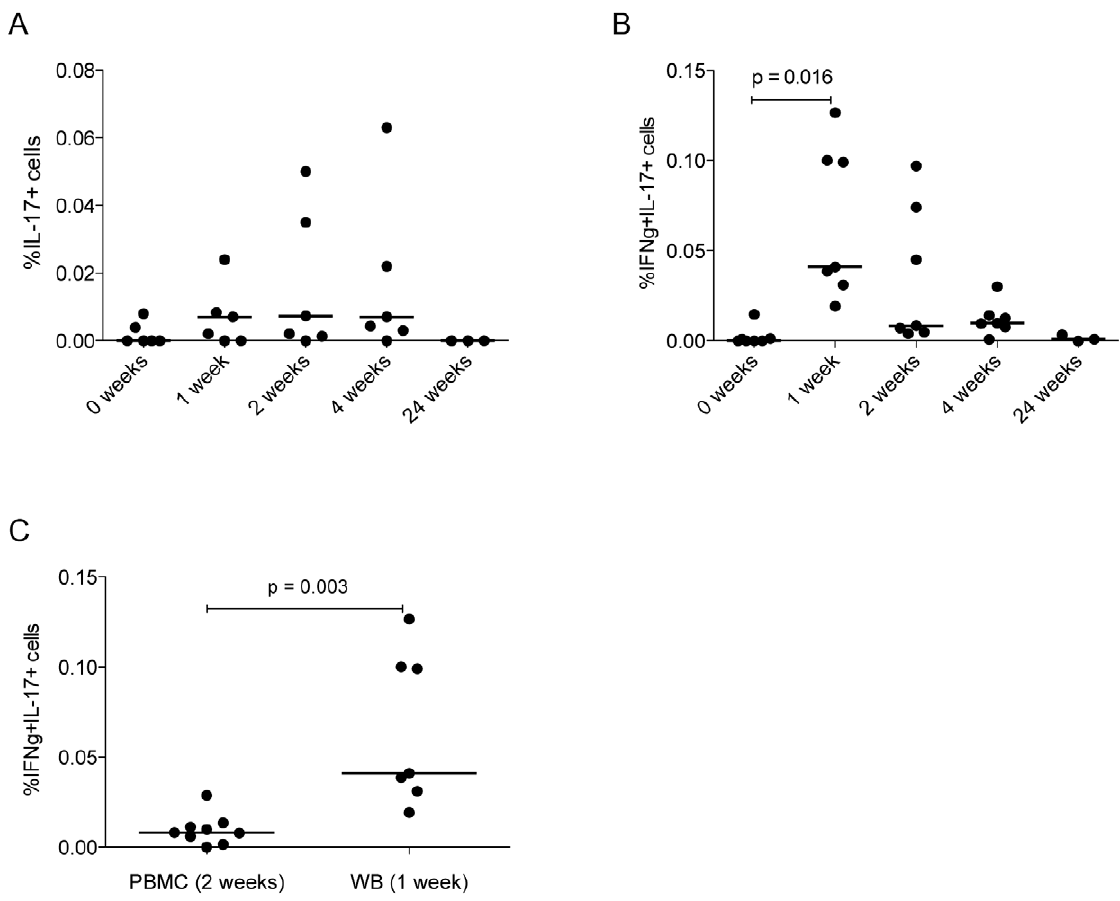
Figure 3. IL-17 and IFN- c production in whole blood peaks 1 week post-vaccination. Whole blood (WB) from vaccinated subjects was stimulated for 6 h with a pool of 66 Ag85A peptides. Phytohaemagglutinin (PHA)-treated and untreated cells were used as positive and negative controls respectively. Lymphocytes were gated for and cytokine-expressing cells quantified as described above. Percentages of IL-17 + and IFN- c + IL- 17 + cells responding to the Ag85A peptide pool (with the percentages from unstimulated cells subtracted) are shown in (A) and (B). Differences in percentages of cells at the relevant peak time point in PBMC vs. WB is shown in (C). n=7.